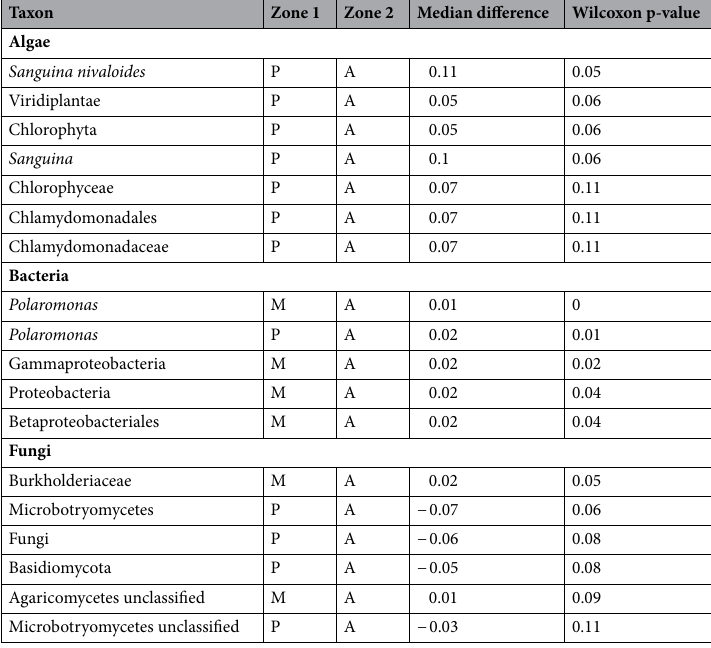
Table 2. Significant OTU comparisons by snow zones medial (M), peripheral (P) and adjacent (A) at varying taxonomic levels (Wilcoxon Rank-Sum; p < 0.10).